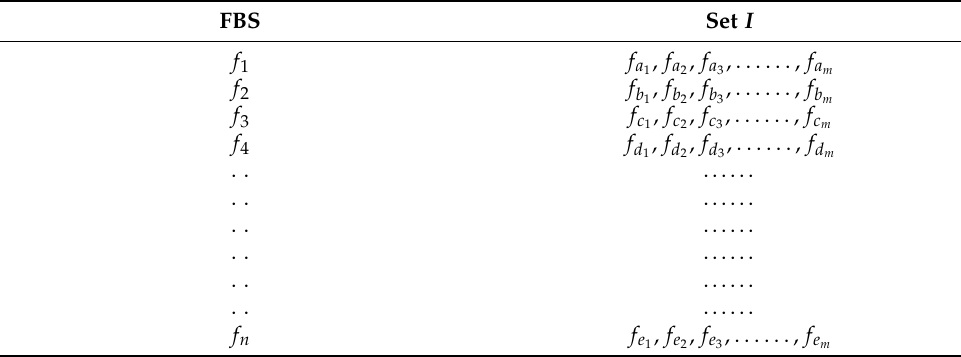
Table 2. Femtocells with their corresponding set of I